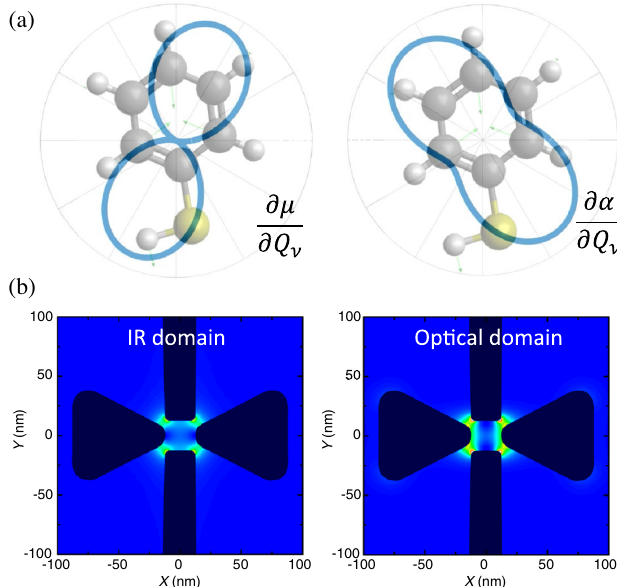
FIG. 2. (a) Polar plots of both the electric moment derivative (left) and the projection of the Raman tensor on the main plane of the molecule (right) for the vibrational mode ˜ ν ¼ 1002 cm − 1 of the thiophenol molecule (background image). (b) Local density of states distribution inside the dual antenna for an IR mode at 32 THz (left) and a NIR mode at 374 THz